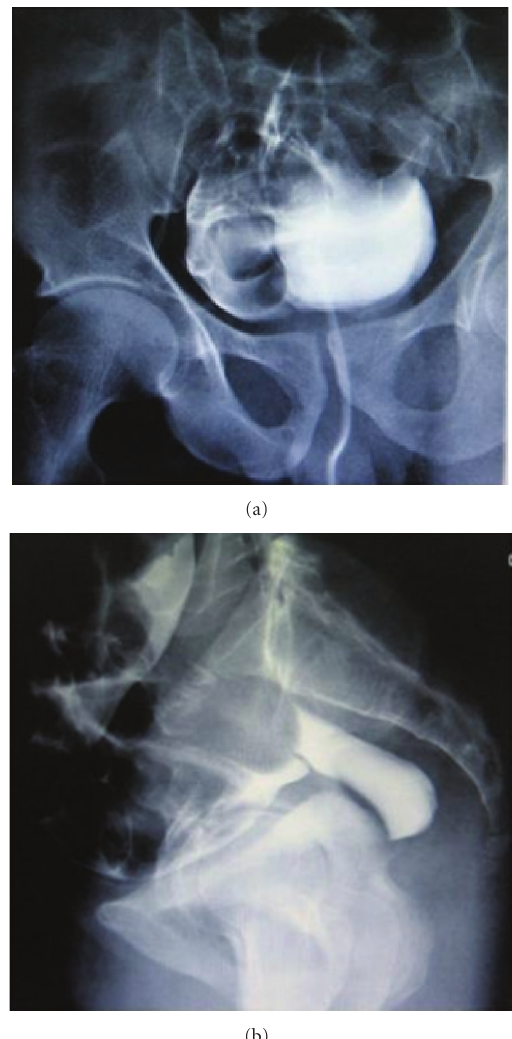
Figure 3: Conventional retrograde cystogram showing extravasa- tion of contrast material outside the UB, denoting intraperitoneal UB